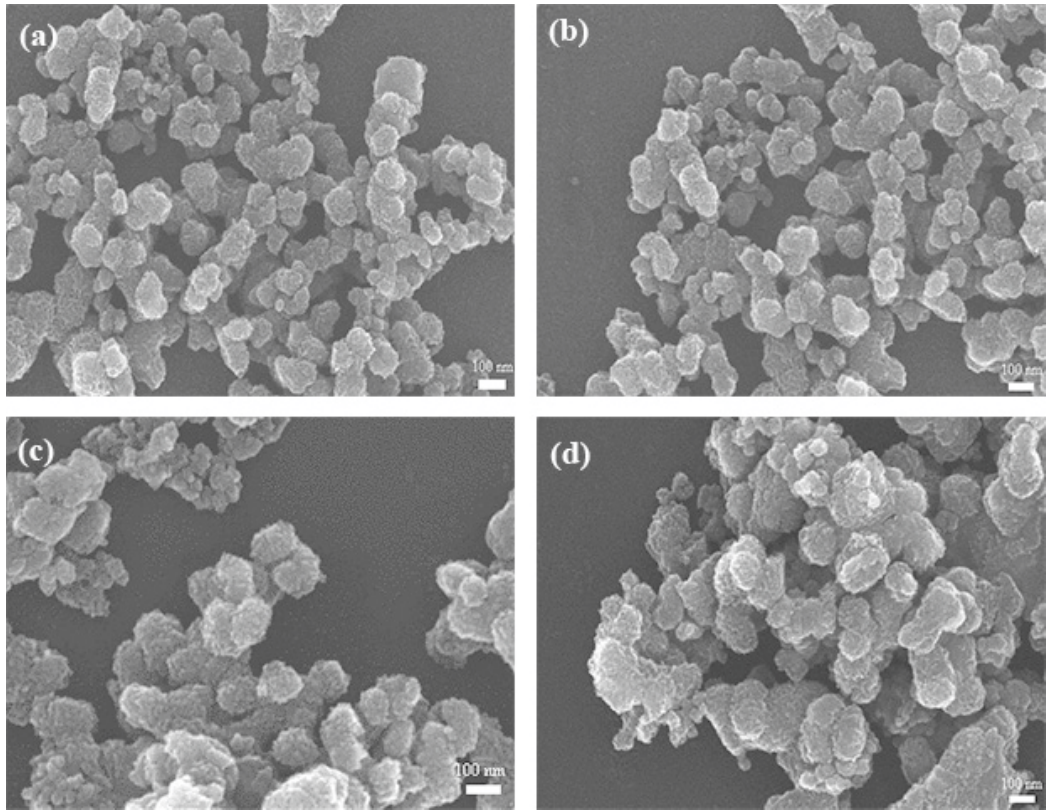
Figure 6 . SEM images of MnO 2 samples prepared under different conditions: ( a ) S(01); ( b ) C(01); ( c ) C(02); ( d ) C(03).